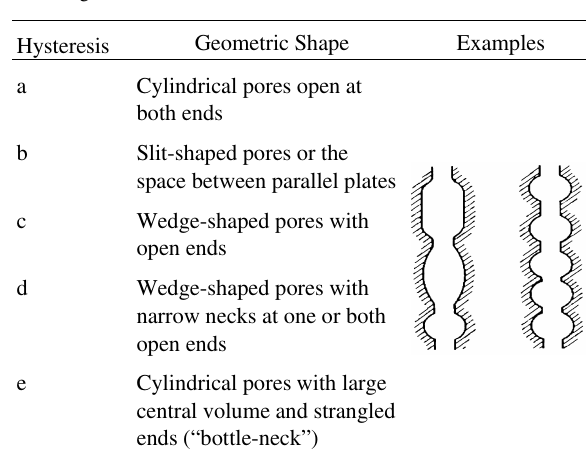
Table 1. Correlation between the type of hysteresis and pore shape, according to de Boer 4